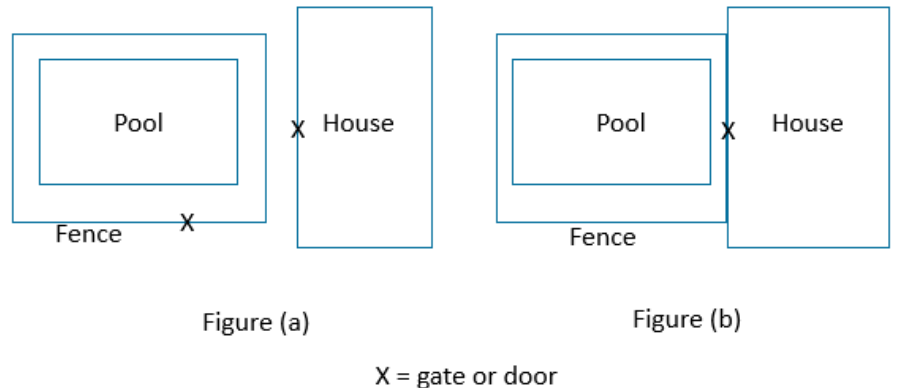
Figure 2. ( a ) Four-sided pool fencing; ( b ) Three-sided pool fencing modified from Australian Standard AS1926.2-2007 [14].